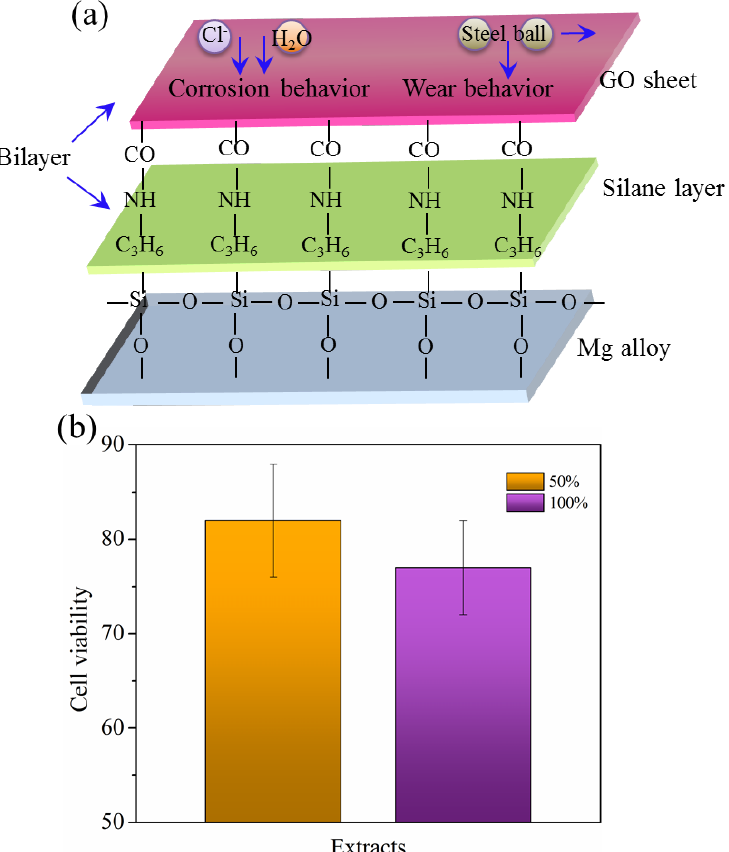
Figure 8. ( a ). Schematic diagram of anti-corrosion and anti-wear mechanisms for AZ91SG, and ( b ) its cytocompatibility for potential biomedical applications by using MG-63 cells.